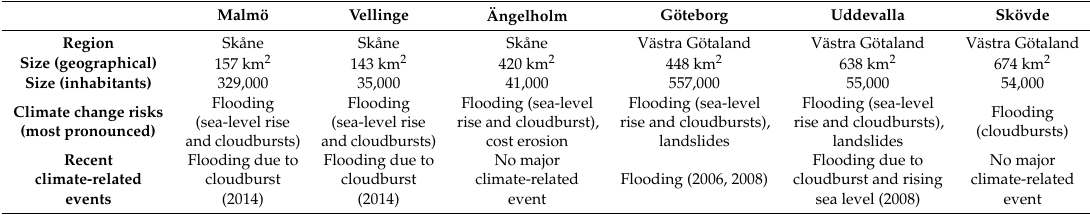
Table 2. Choice of municipalities. Information about size and climate-related